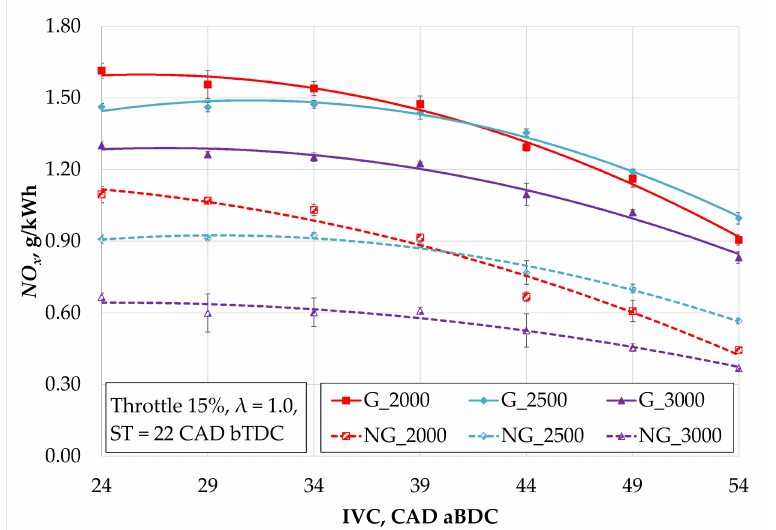
Figure 13. Changes in the specific NO x emissions from an engine running on gasoline and natural gas and while changing the intake valve close